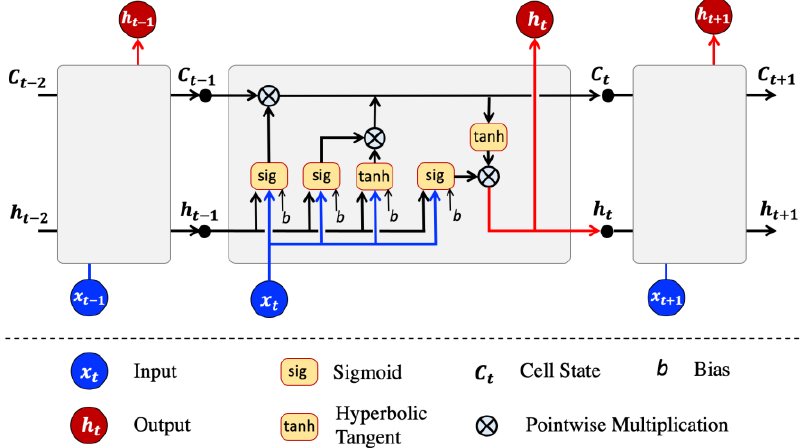
Figure 1. The architecture of a Long Short-Term Memory (LSTM) network. In addition to the original LSTM, Convolutional Long Short-Term Memory (ConvL- STM) is also used in the travel time prediction problem [14]. The ConvLSTM is an extension of LSTM that uses convolutional layers to process input. This approach is suitable for large input matrices, such as images. There are studies, such as [14], that have taken advantage of this method to predict the travel time of buses and have found that the ConvLSTM prediction model provided the best performance. In addition, the work in [22] also used the ConvLSTM in a travel time prediction